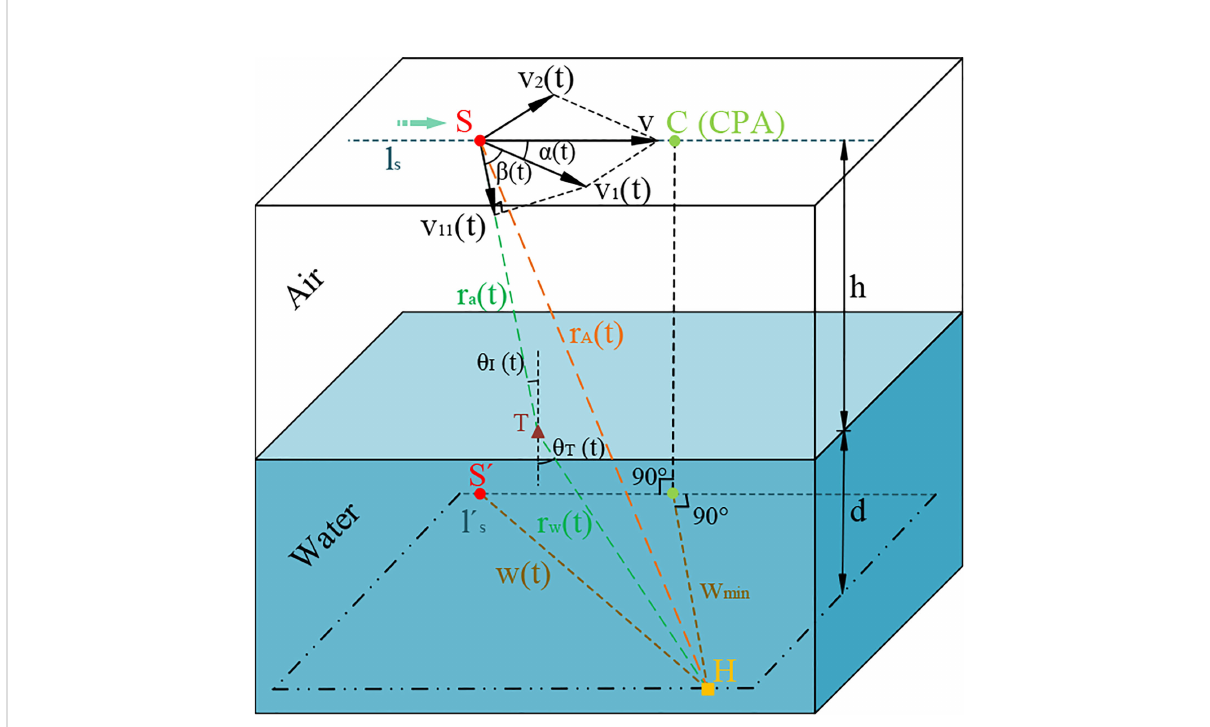
FIGURE 1 General geometrical con fi guration for a hydrophone node in the water and the linear trajectory of a source in the air as it transits past the hydrophone node in a straight line at constant velocity v , constant altitude h , and certain slant range w